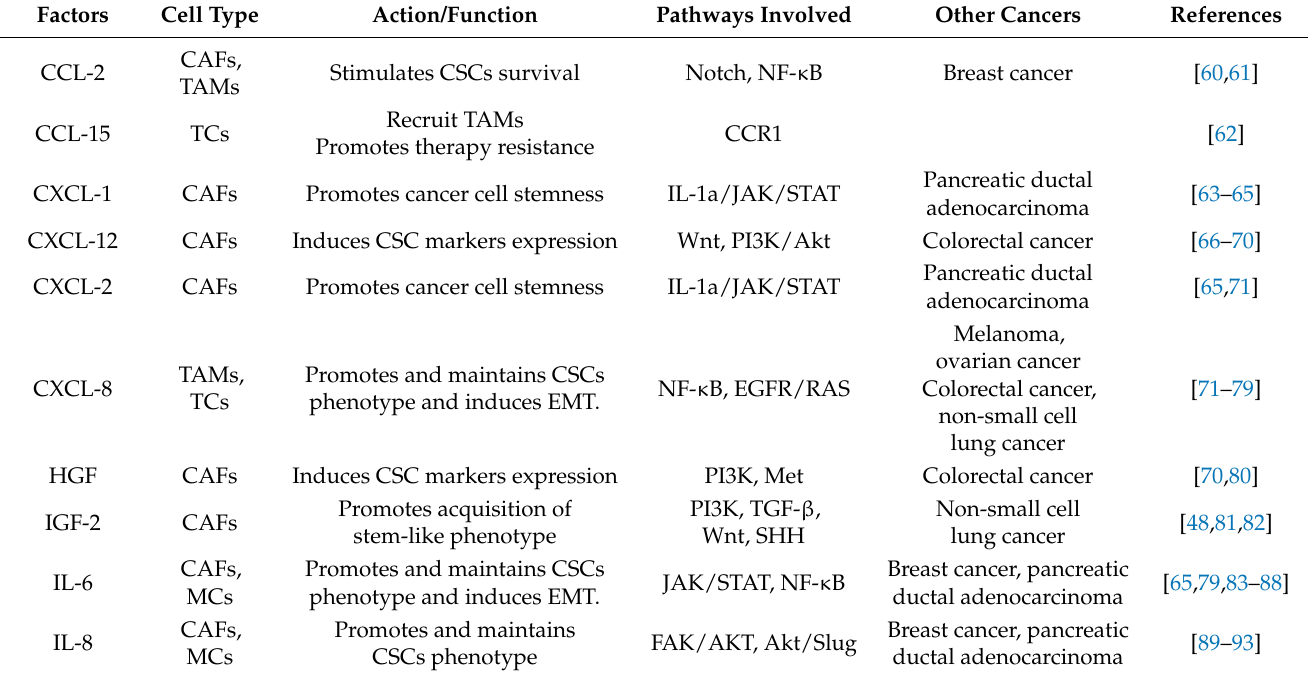
Table 2. Secreted factors that promote CSCs’ phenotypes and